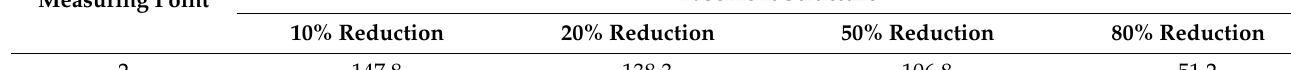
Measuring Point